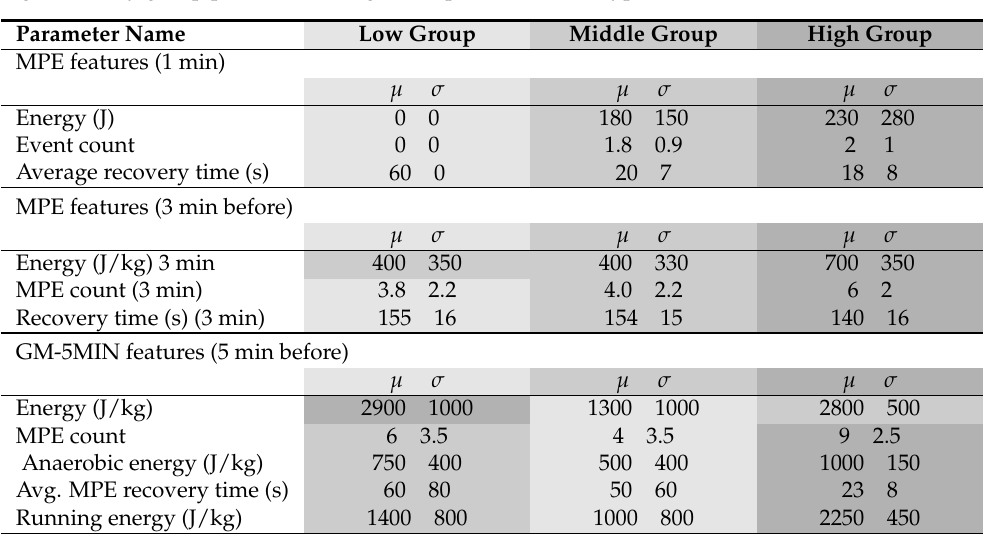
Table 3. Clustering group results. Darker background color represents higher intensity. The low- intensity group shows no MPE activity in the observed minute, but this is likely a result of very high expenditure in the 5 min period that preceded it. The middle-intensity group exhibits higher expenditure according to MPE features but shows lower values of GM-5MIN in 5 min prior. The high-intensity group produces the highest expenditure in all types of